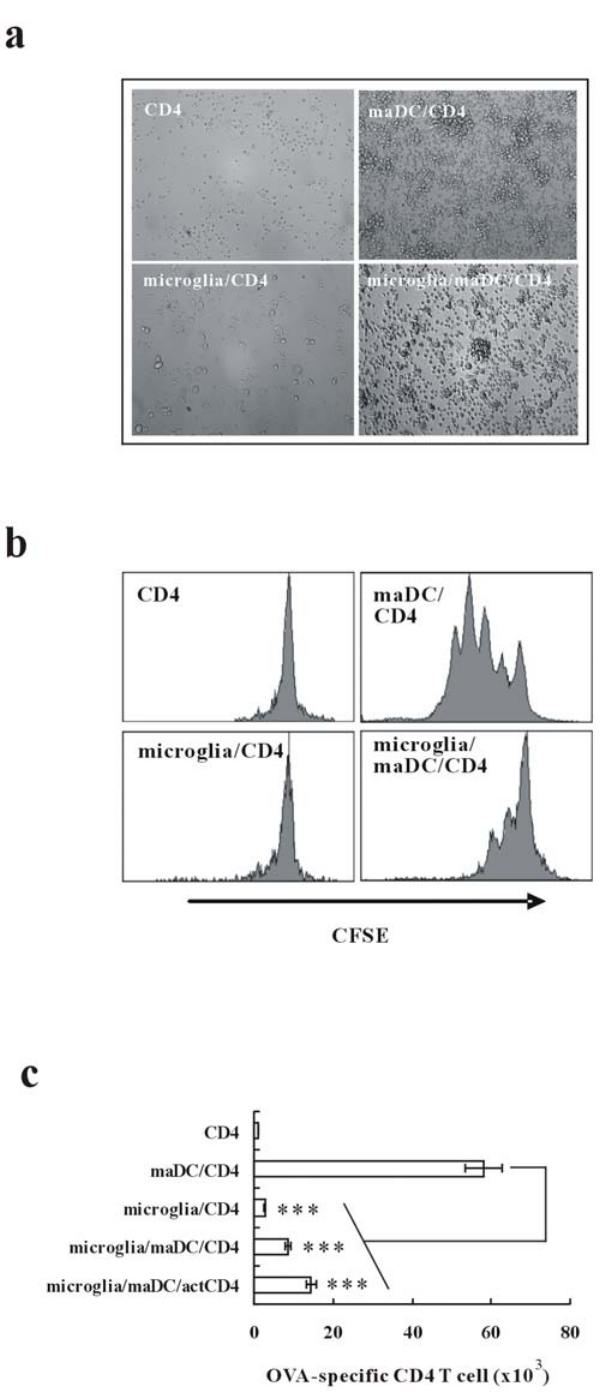
Figure 1. Microglia inhibit maDC-initiated proliferation of CD4 T cells. CD4 T cells from DO11.10 6 C57BL/6 F1 hybrid mice were cocultured with maDCs or/and microglia for 5 days. (a)The photos were taken in bright field (objective 6 20). (b) The proliferation of CFSE- labeled CD4 T cells was detected by FACS after 3 days coculture. (c) The live CD4 T cells in the coculture system were counted by FACS. Data are presented as mean 6 s.d. of triplicate wells and representative of three independent experiments. *** P ,